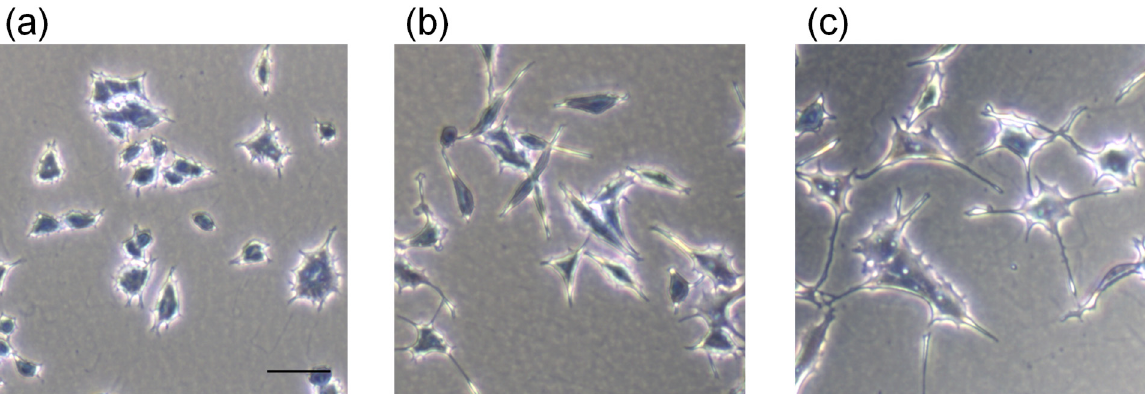
Figure 3. Photomicrographs of PC12 cells treated with medium only ( a ), 0.5 mM Bt 2 cAMP ( b ), and mixture of 2 μ M valine and 0.5 mM Bt 2 cAMP ( c ). PC12 cells were plated at 4.0 × 10 3 cells/well and cultured with medium only, Bt 2 cAMP at 0.5 mM, or mixture of valine at 2 μ M and Bt 2 cAMP at 0.5 mM. After 24 h, treated cells were fixed with 1% glutaraldehyde and stained with Giemsa stain solution. Scale bar = 50 μ m.